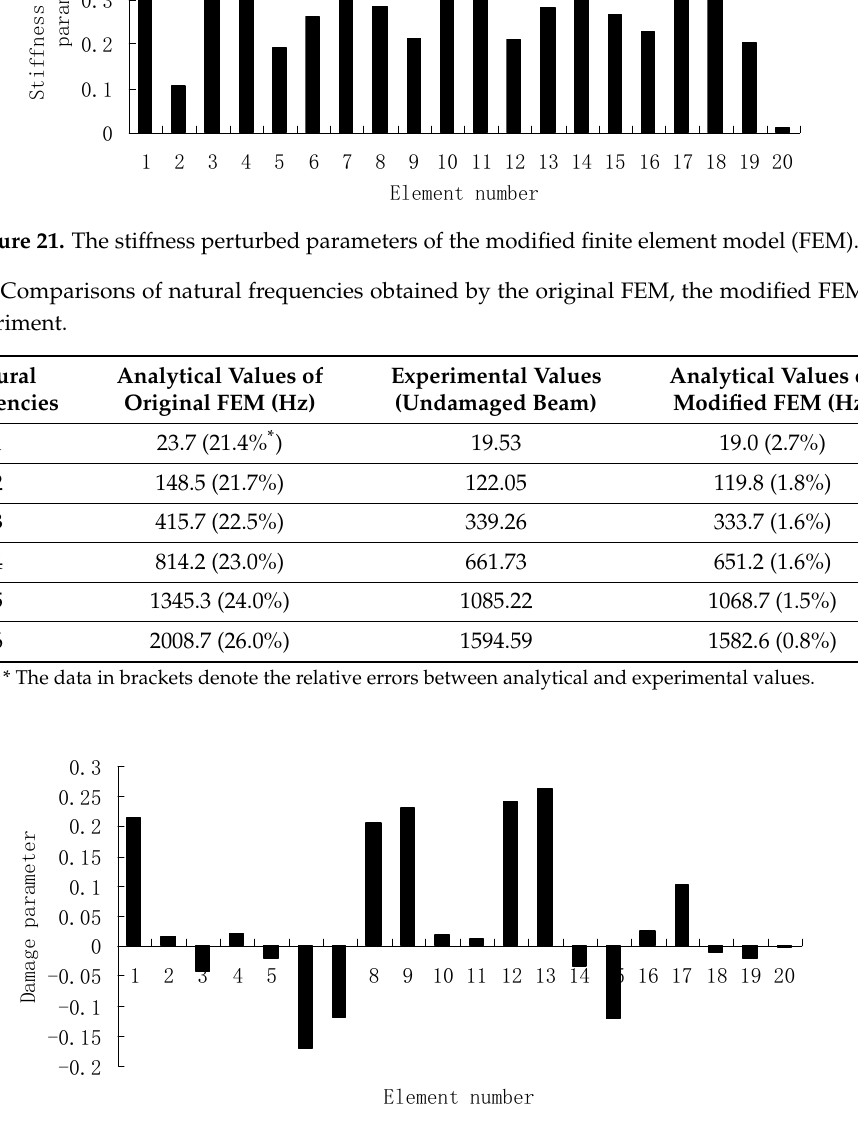
Figure 22. Damage evaluation result by the first computation of ESVT for the experimental beam.